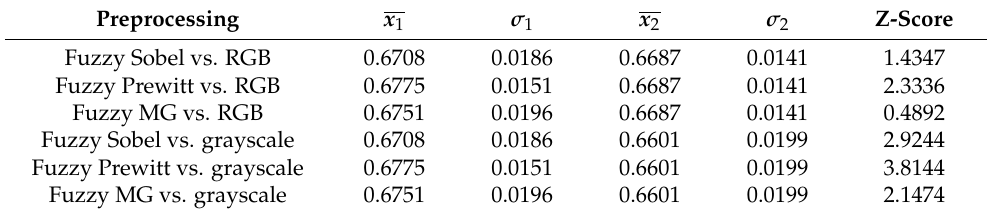
Table 9. Hypothesis test results for CNN-I model.